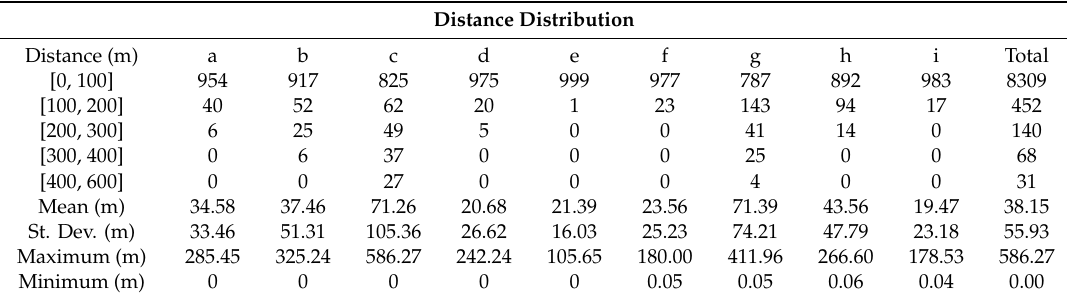
Table 4. Deviation between the coastline in 2010 from our method and the manually extracted coastline for the nine areas (in meters). Areas (a–i) are marked in Figure